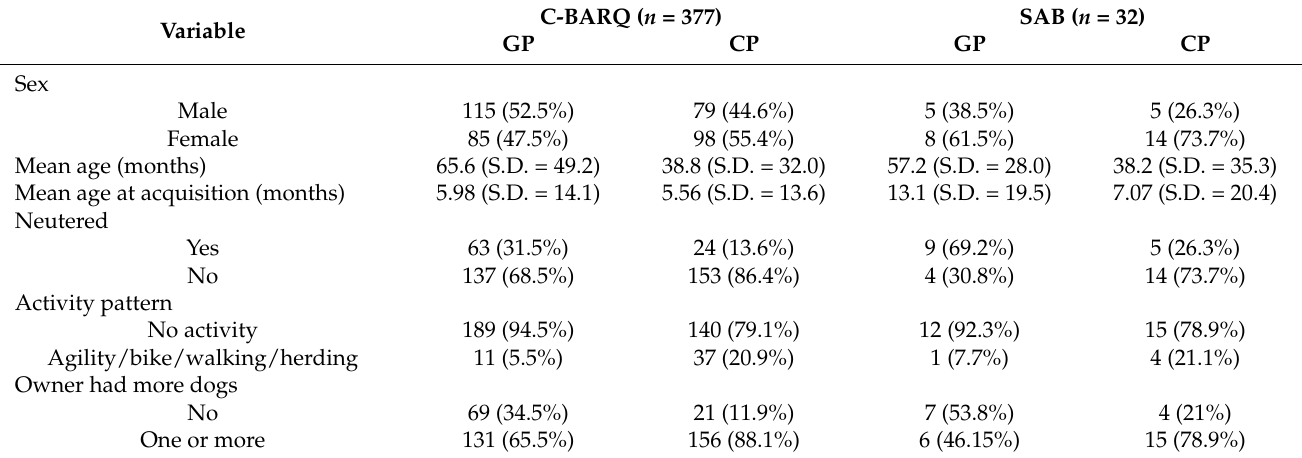
Table 2. Descriptive analysis of the studied dog